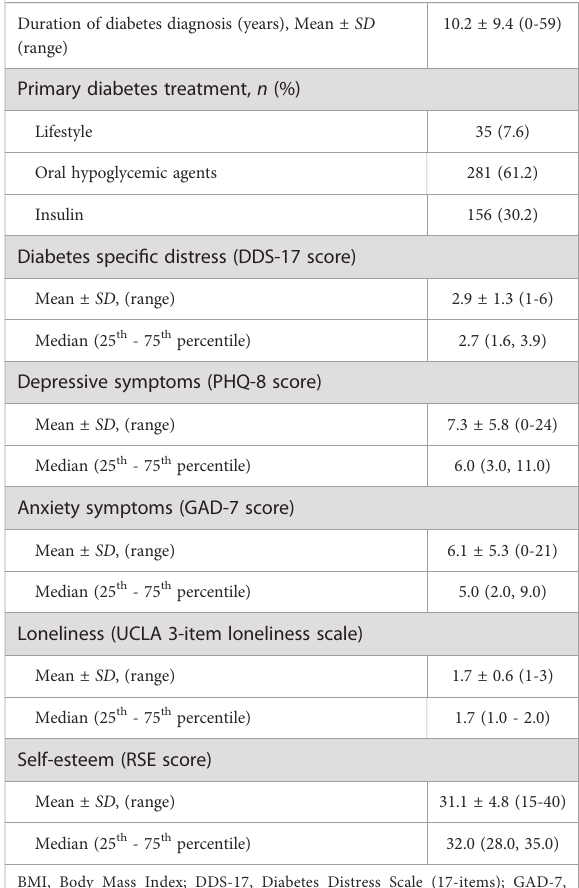
TABLE 1 Characteristics of study participants ( N